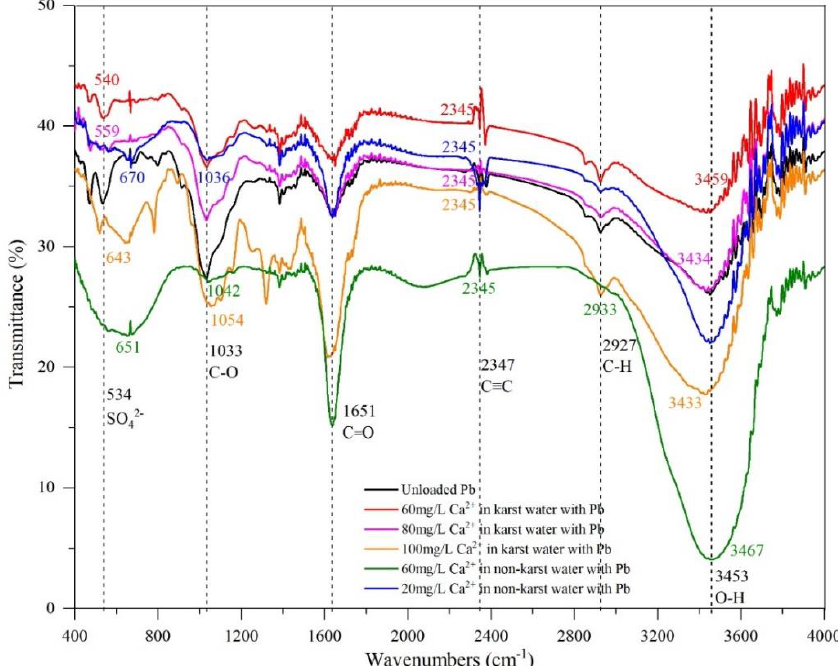
Figure 4. Transmittance spectrum of E. crassipes roots before and after absorbing Pb in water with different Ca 2+ concentrations.